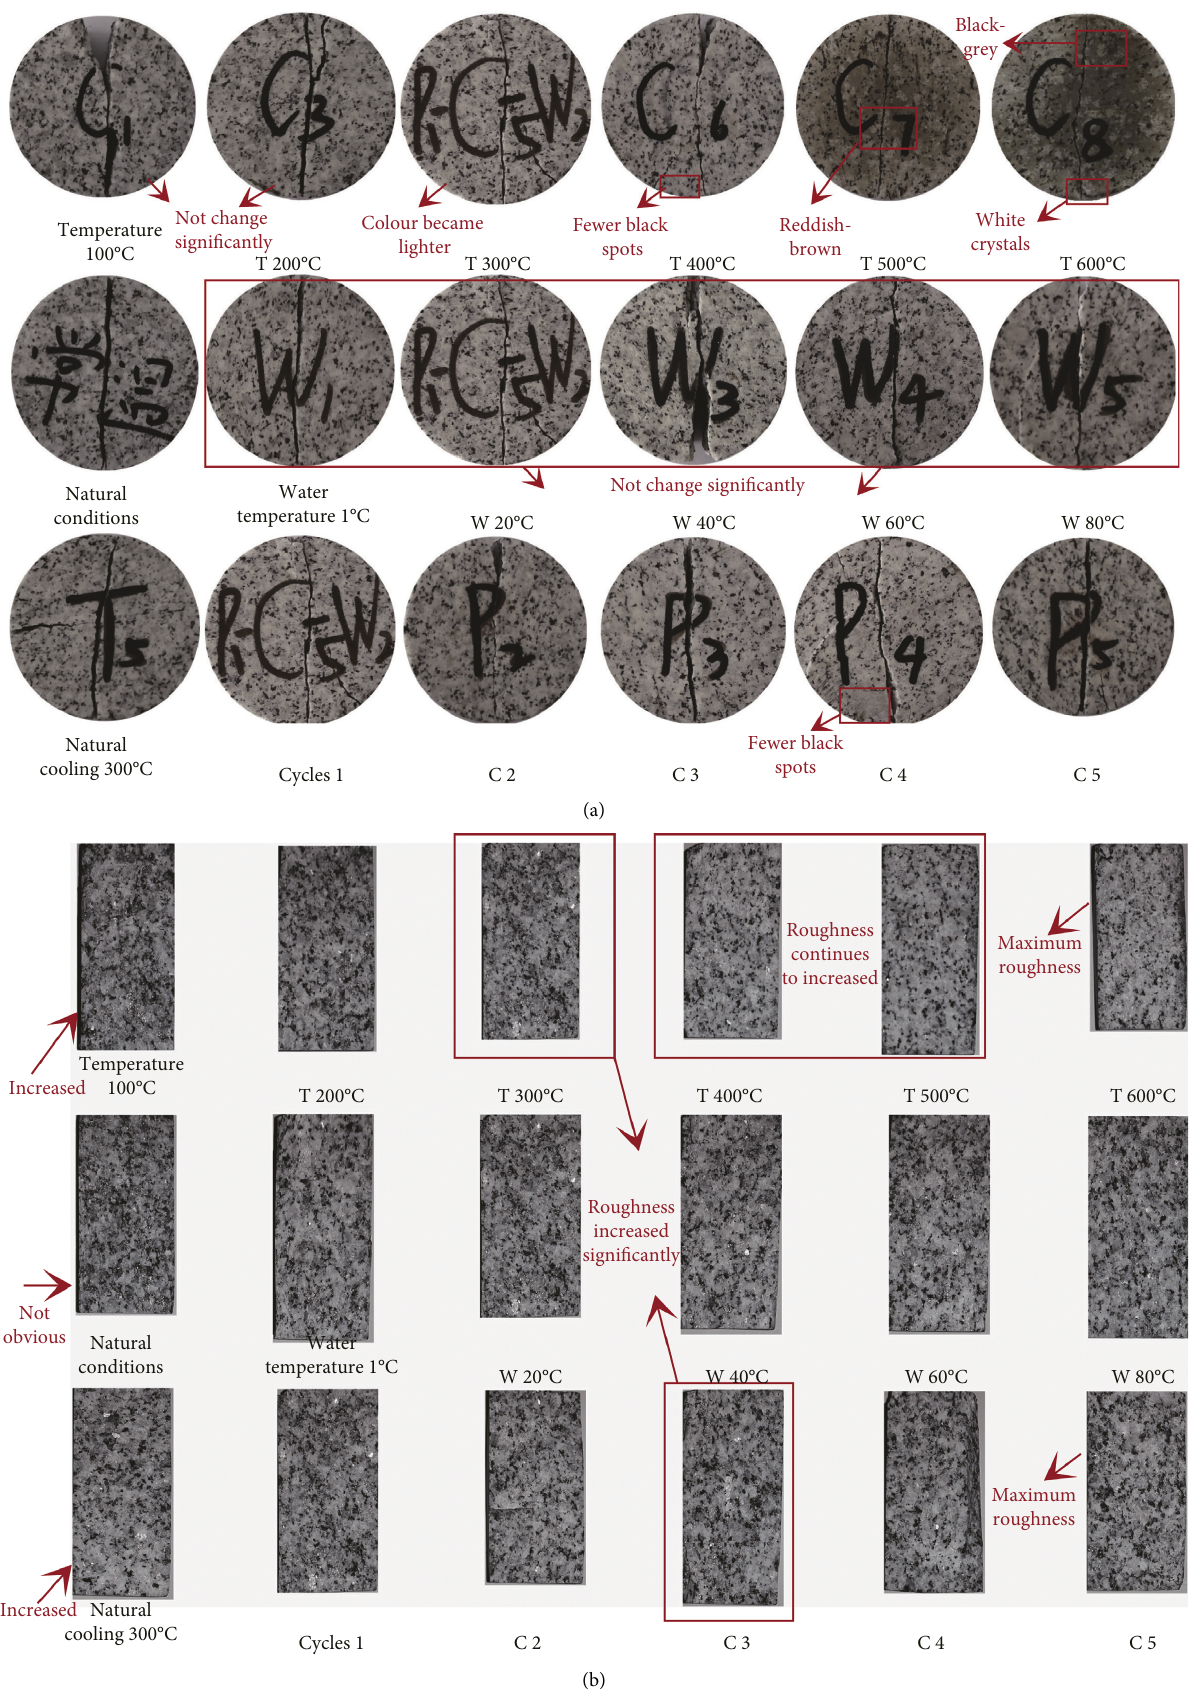
Figure 4: Appearance characteristics of the specimens after splitting under different conditions of water cooling at high temperature. (a) Front view. (b) Side